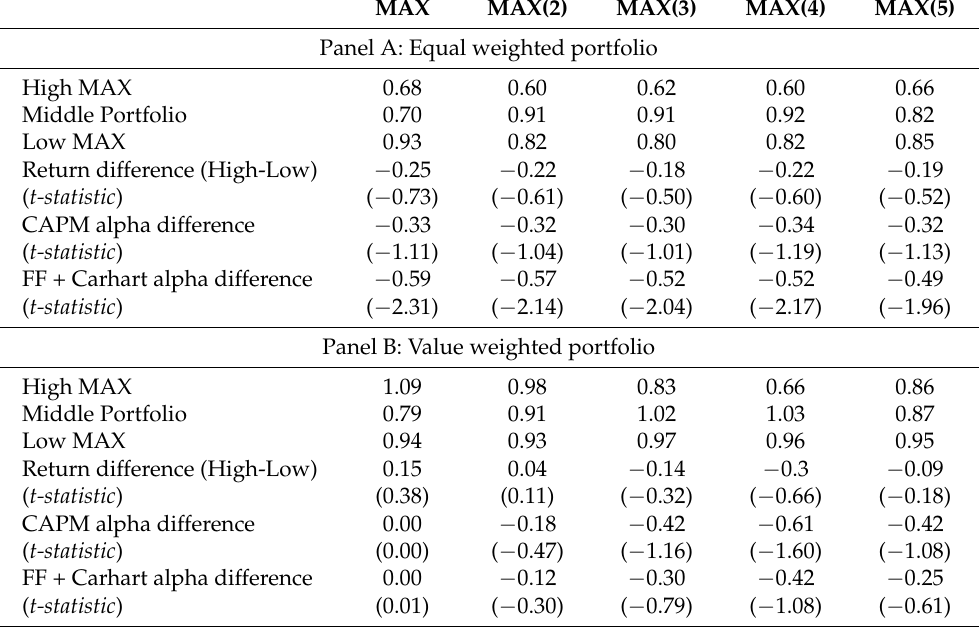
Table 2. The table reports mean returns on MAX(N)-sorted portfolios and the difference between mean returns and risk-adjusted returns of high- and low-MAX portfolios with the associated Newey and West (1994) adjusted t-statistics . We use the Oslo all-share index as the market factor in CAPM and the four-factor model of Fama and French (1996) and Carhart (1997). Three portfolios are formed and re-balanced on the first trading day each month, sorted on MAX(N). All figures are percentages.